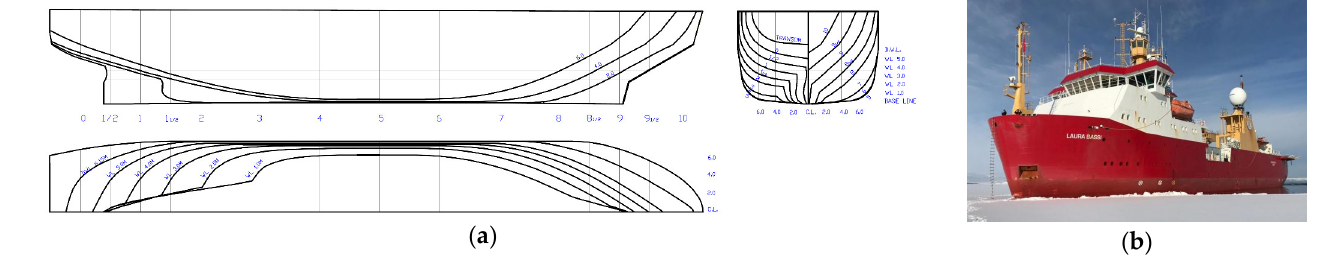
Figure 1. The research ship “Laura Bassi”: ( a ) Laura Bassi line drawing; ( b ) Laura Bassi image. From the data gathered during the voyage of the “Laura Bassi” research ship, two sets have been chosen for the analysis, each with a 1 h duration and a 1 Hz sampling rate. It is specified that the image in Figure 1b is only representative of the usual activities of the “Laura Bassi” ship, but that the ship motions were recorded in ice-free conditions. The voyage data are reported in Table 2 and Figure 2; the ship velocity is considered as the mean value during each data collection.